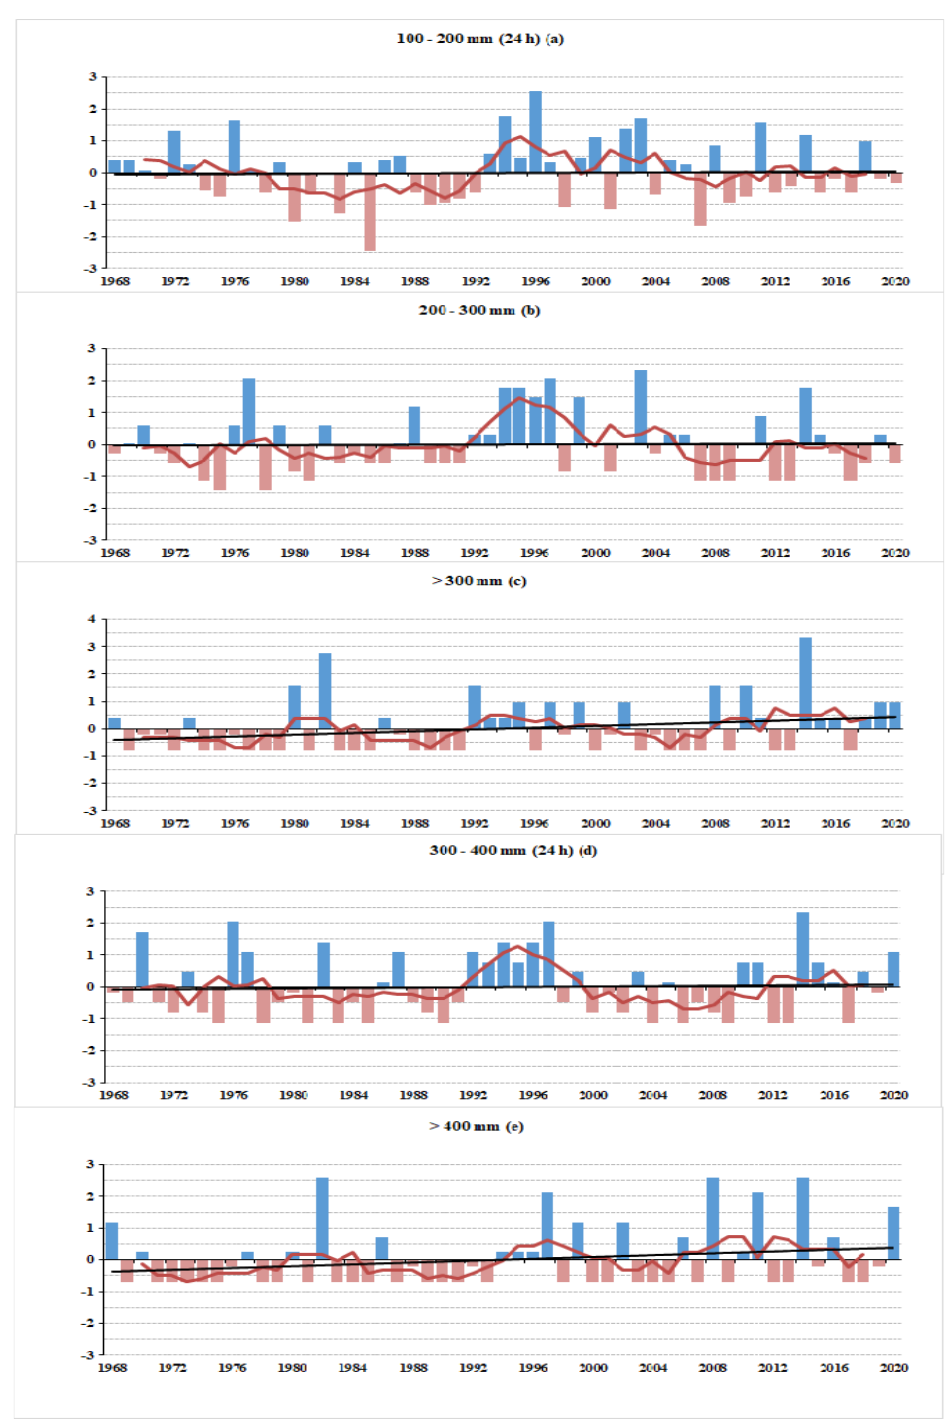
Figure 3. Centred ‐ small deviations of annual observation frequencies of rainy days with intensities above 100 mm in 24 h in the 9 departments of the Mediterranean area (1968–2020) ( RI = ( 𝑋𝑖 − 𝑋 )/ S ‐ where 𝑋𝑖 is yearly value, 𝑋 is the series average and 𝑆 is standard deviation).